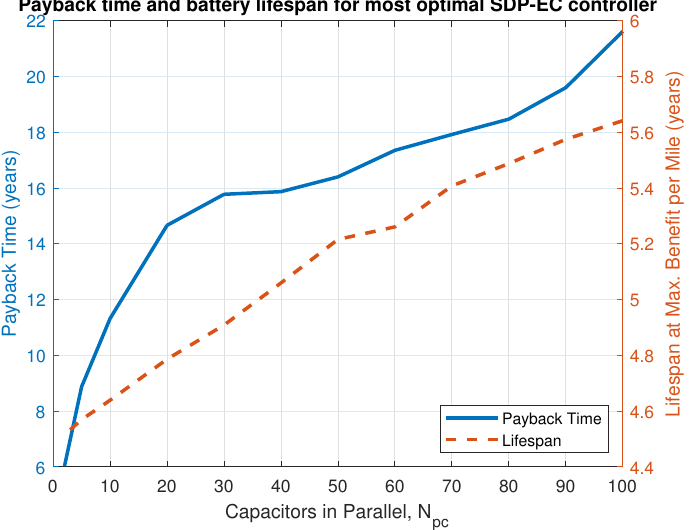
Figure 15. Estimated payback time for optimal SDP-EC controller with varying HESS size. Finally, the authors note the sensitivity of the benefit per mile and the payback time period to assumptions about component pricing, energy pricing, and aging